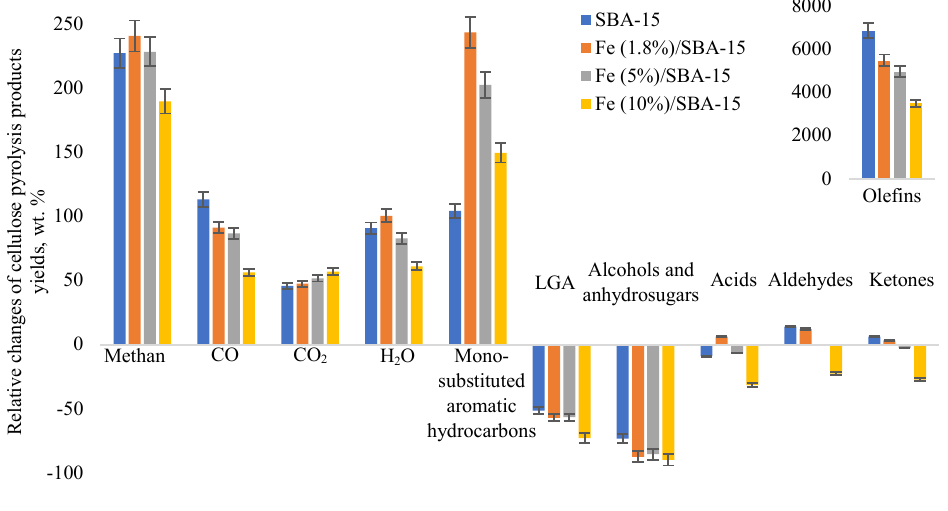
Fig. 4. Relative changes of catalytic cellulose pyrolysis products yields compared to non-catalytic pyrolysis product